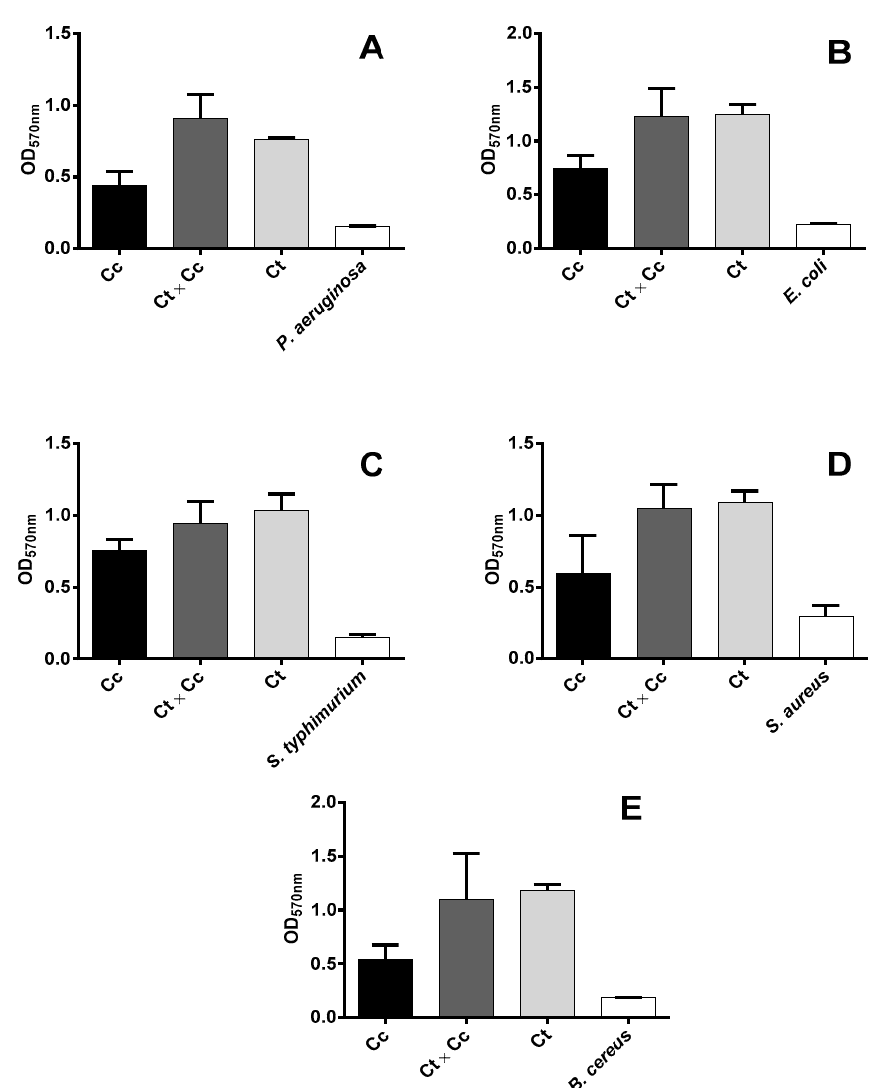
Figure 3. Biofilm formation in the presence of kino extracts from Corymbia citriodora (Cc), C. torelliana × C. citriodora (Ct × Cc), and C. torelliana (Ct) by ( A ) Pseudomonas aeruginosa , ( B ) Escherichia coli , ( C ) Salmonella typhimurium , ( D ) Staphylococcus aureus , and ( E ) Bacillus cereus . Optical densities at 570 nm wavelength (OD 570nm ) are presented as mean + S.E. ( n = 3 trees for Cc, Ct × Cc, and Ct; n = 3 for